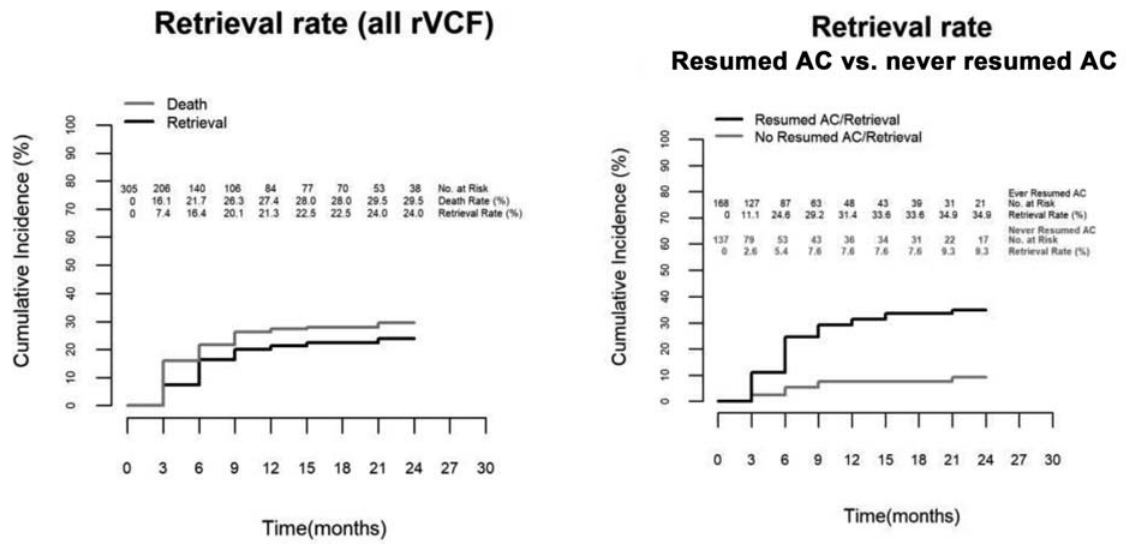
Fig. 3 ( A ) Cumulative incidence of VCF retrieval over 2-year follow-up accounting for death as a competing risk in overall retrievable fi lter population. VCF, vena cava fi lter; VTE, venous thromboembolism. ( B ) Cumulative incidence of VCF retrieval over 2-year follow-up accounting for death as a competing risk in retrievable fi lter population who ever resumed AC versus who never resumed AC. AC, anticoagulation; rVCF, retrievable vena cava fi lter; VTE, venous